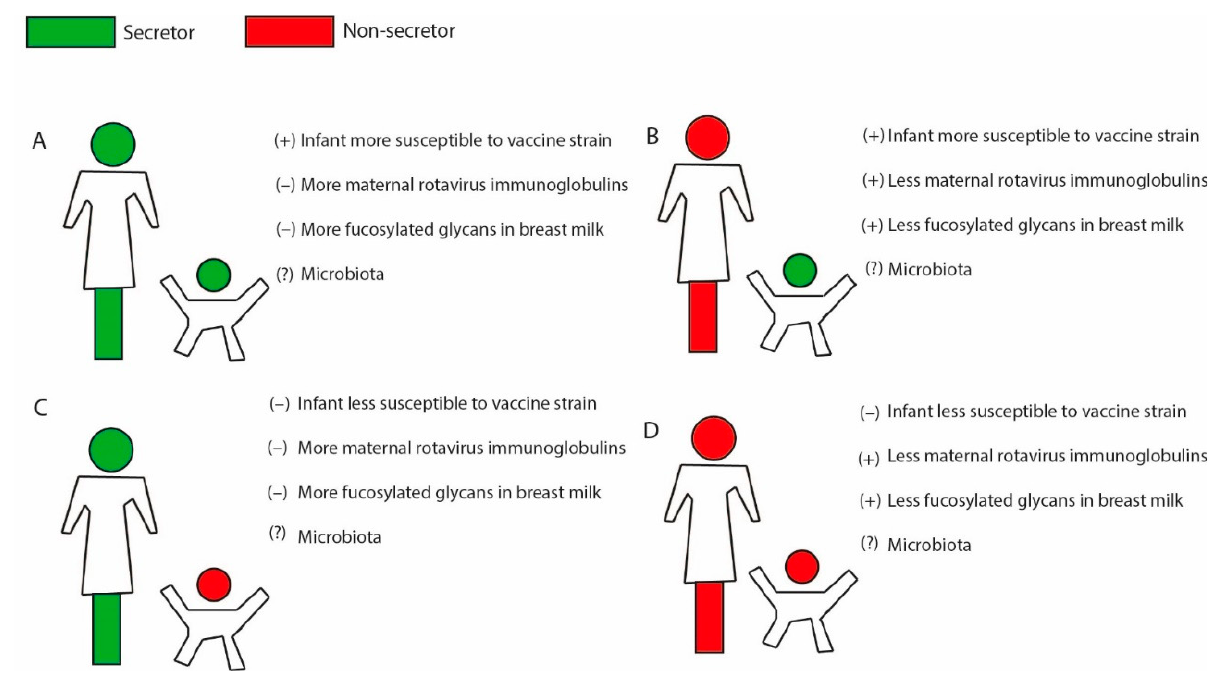
Figure 1. A simplistic overview on how secretor status in both mother and infant affects several factors that, in turn, may restrict rotavirus vaccine take. ( A ) Both mother and infant are secretors. In such a scenario, the positive secretor status of the child favors susceptibility to live oral rotavirus vaccines with a P[8] component such as Rotarix and RotaTeq, while higher levels of rotavirus-specific maternal antibodies (IgG, IgA) and anti-rotavirus effect by IgA and/or fucosylated glycans in breastmilk might limit vaccine take. ( B ) Mother is non-secretor, and infant is a secretor. Here, the secretor-positive infant will be more susceptible to live oral rotavirus vaccines (Rotarix and RotaTeq), while lower rotavirus-specific maternal antibodies and lower of levels of IgA and/or fucosylated glycans in breastmilk may also increase vaccine take. ( C ) Mother is a secretor and infant is a non-secretor. The infant will be less susceptible to live oral rotavirus vaccines due to negative secretor status. Higher levels of maternal rotavirus antibodies and anti-rotavirus effect of breastmilk might further restrict vaccine take. ( D ) Both mother and infant are non-secretors. Infant will be less susceptible to live oral rotavirus vaccine, while lower levels of maternal rotavirus antibodies and lower anti-rotavirus effect of breastmilk might benefit vaccine take. The different scenarios will also influence infant microbiota composition, but specific effects on rotavirus vaccine take are unclear. Following this model, it is proposed that scenario B will be most beneficial in terms of vaccine take, while scenario C will be the least beneficial. It is important to note that the same factors restricting vaccine take also provide protection of the infant to natural rotavirus infections. Note: (+) and (–) indicate higher and lower vaccine take, respectively, while (?) represents unknown